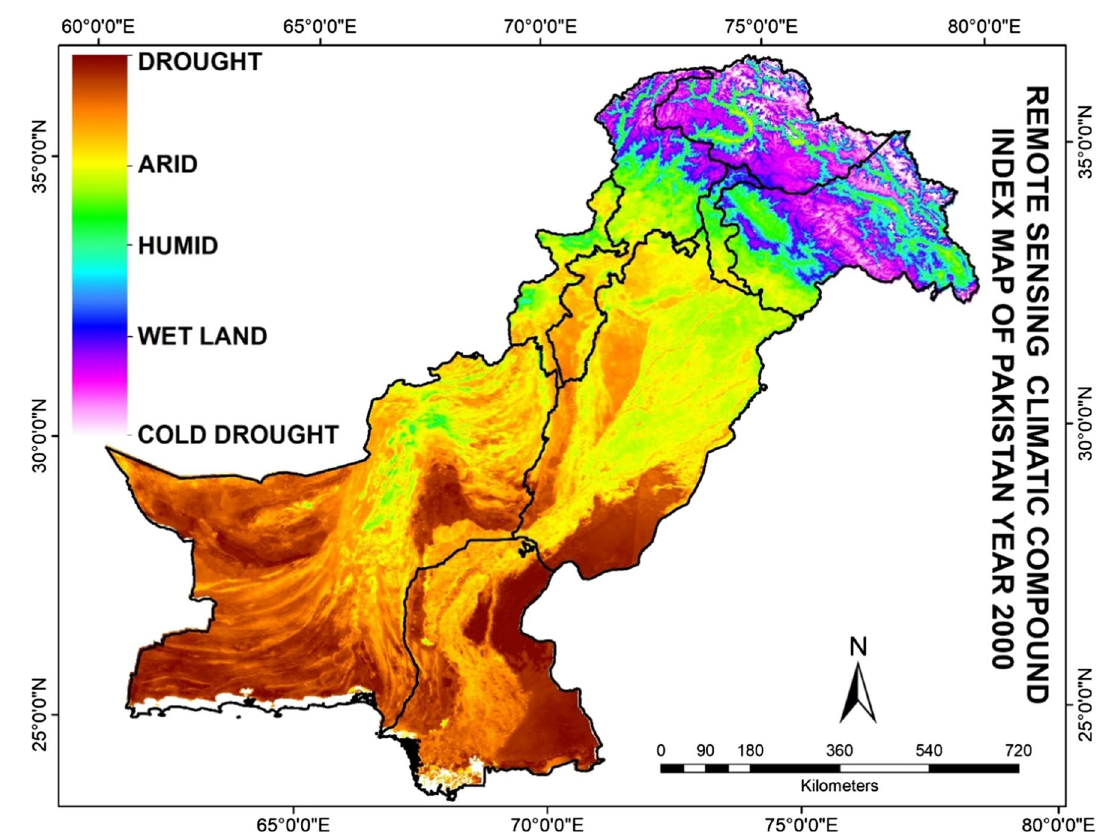
Fig. 2 The new climatic classification of Pakistan by using remotely sensed images collaborated with compound indices for year 2000. This figure shows new climatic classification for year 2000 into fur- ther major five classes name as drought, arid, humid, wetlands and